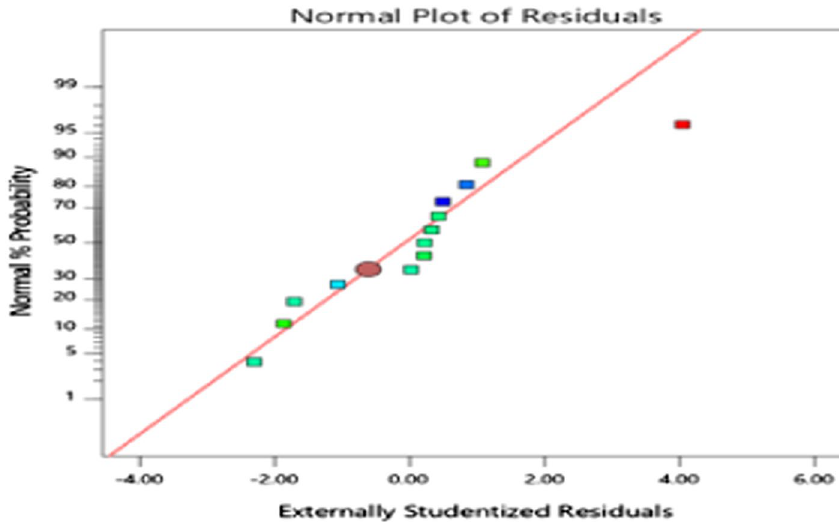
Fig. 6 Normal % probability vs. residual plots for